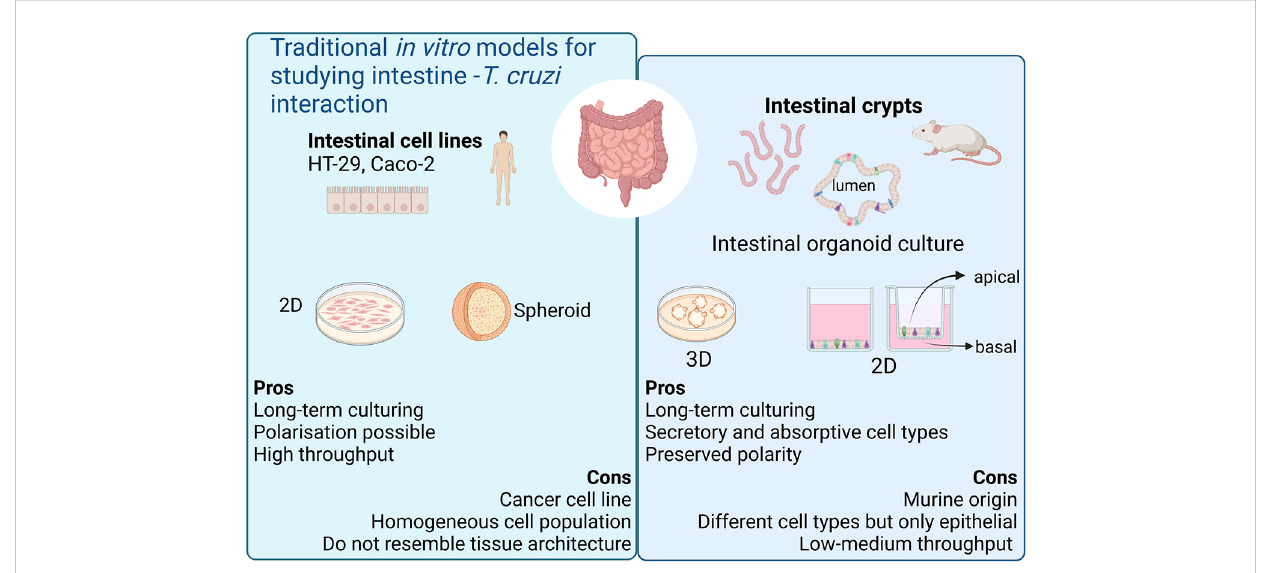
FIGURE 1 Current in vitro models for modeling chronic Chagas Disease. Created with BioRender.com (agreement number